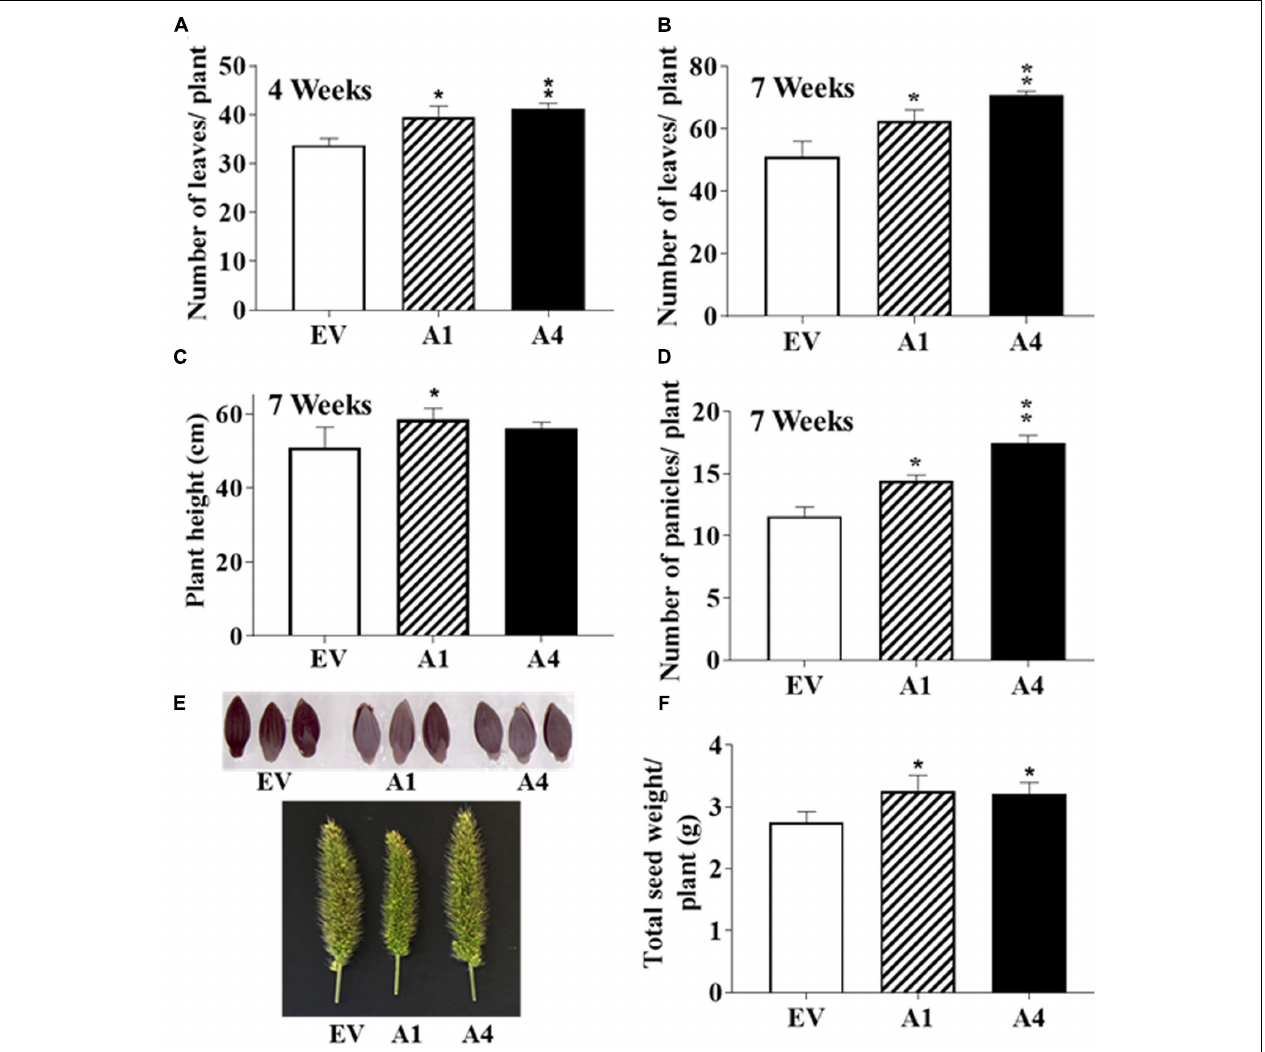
FIGURE 4 | Effect of AGG3OE on adult S. viridis plants. Adult plant phenotypes of EV, A1 and A4 plants grown under control conditions. Twelve plants per genotype for each of the transgenics were evaluated. The parameters measured were (A) number of leaves at 4-weeks, (B) leaf number at 7-weeks, (C) plant height at 7-weeks, (D) number of panicles per plant at 7-weeks. (E) Representative pictures of the panicles and seeds of EV versus A1 and A4 transgenic plants. (F) The total seed yield per plant. The data represent mean values ( ± SE) of three biological replicates. Asterisks represent P -values ≤ 0.05 ( ∗ ) or ≤ 0.01 ( ∗∗ ) as calculated using Students t-